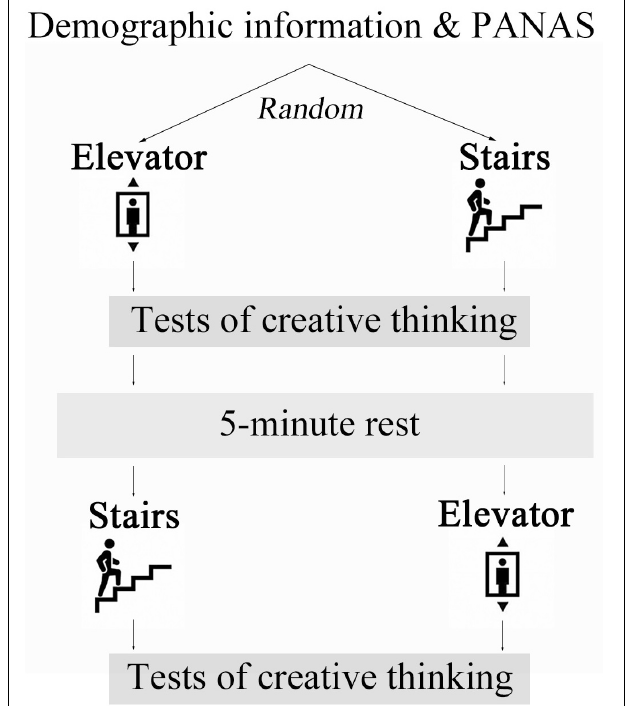
FIGURE 1 | Schematic illustration of the